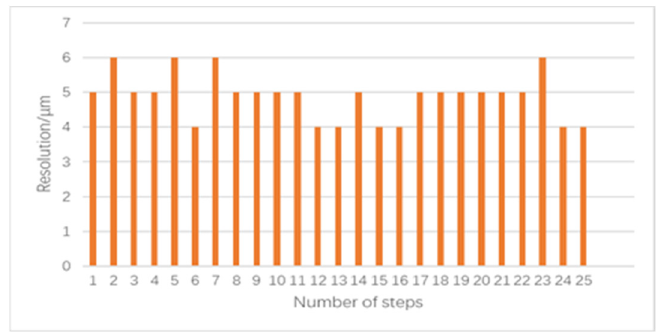
Figure 11. Results of motion resolution tests for displacement along the z-direction.